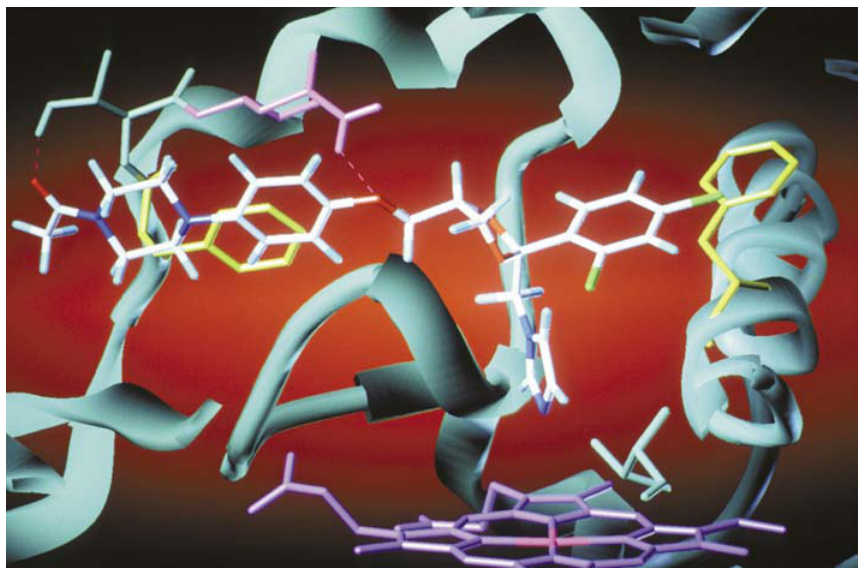
FIGURE 2. The putative active site of CYP3A4 showing the selective inhibitor, ketoconazole, orientated for heme ligation via a combination of hydrogen bonding (dashed lines) and π - π stacking with complementary aromatic residues (shown in yellow). Ketoconazole is coloured by atom type (carbon - white, hydrogen - pale blue, nitrogen - blue, oxygen - red, chlorine - green), whereas the amino acid residues are coloured by type (amides in magenta; aromatic residues in yellow; hydroxyl sidechains in pale green; hydrophobic residues in pale blue; acidic residues in red; basic residues in blue). The heme moiety is shown in purple and the iron atom is at its